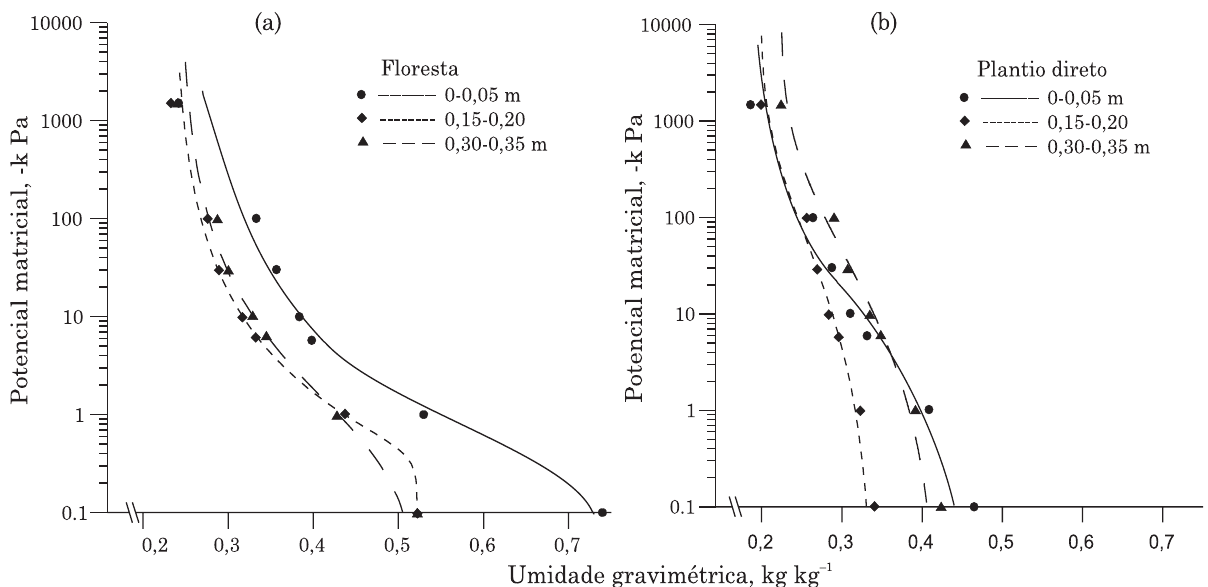
Figura 1. Retenção de água obtida (pontos) e curva de retenção de água ajustada pelo modelo Van Genuchten (linhas), para o Latossolo Vermelho eutrófico sob dois sistemas de manejo: floresta (a) e plantio direto (b), em três